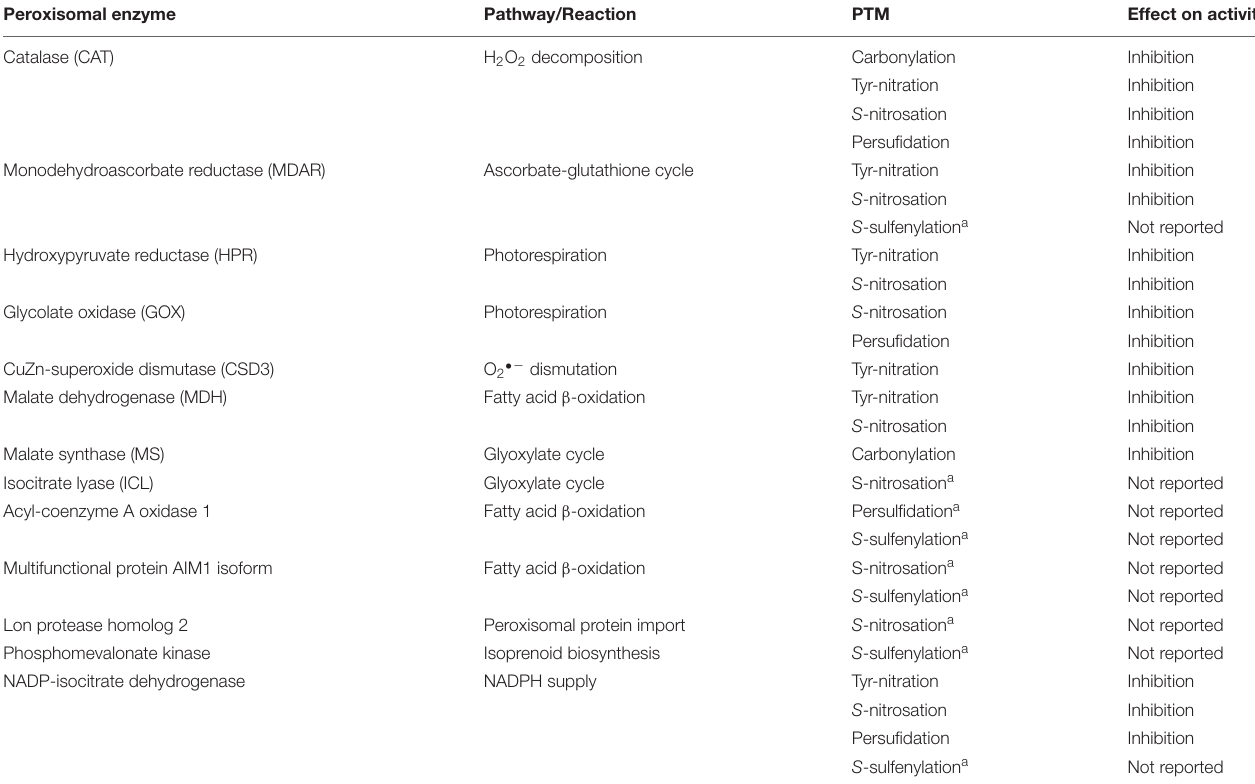
TABLE 1 | Peroxisomal enzymes target of diverse posttranslational modifications (PTMs) whose activities are affected by either ROS, RNS, or RSS. Peroxisomal